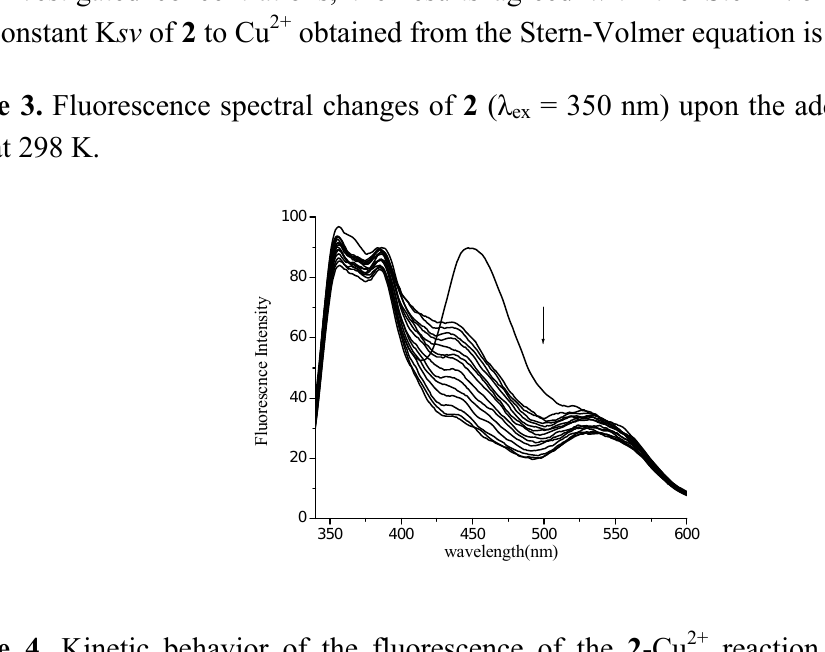
Figure 4. Kinetic behavior of the fluorescence of the 2 -Cu 2+ reaction system in THF solution. [ 2 ] = 1.00 × 10 − 5 M, [Cu 2+ ] = 1.00 × 10 − 5 M.